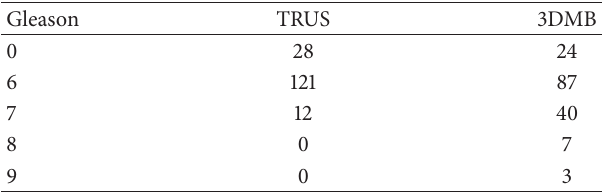
Table 1: Gleason grade